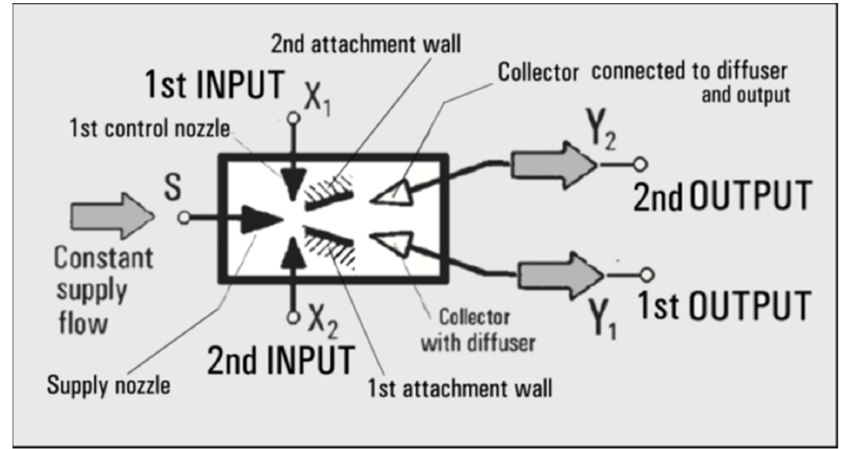
Figure 4. Schematic representation of the amplifier and its components used for drawing circuit diagrams. Black triangles are symbols for nozzles (cross-section area decreases in the flow direction), white triangles are collectors and connected diffusers (cross-section area increasing in the direction of flow).